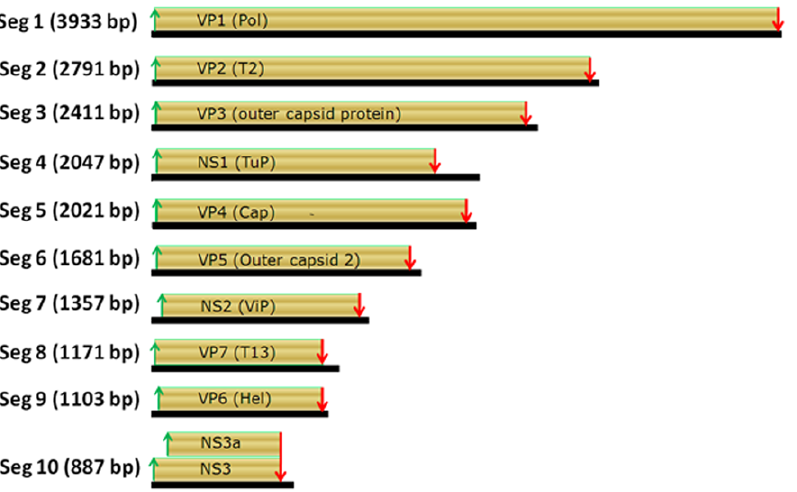
Figure 2. Genome organization of Umatilla virus (UMAV), containing 10 dsRNA segments, each contain an ORF, except Seg-10, which contains two ORFs. The green and red arrows indicates the start and stop codon of the ORF